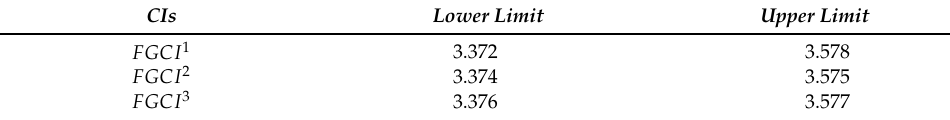
Table 4. Confidence intervals with 2.5% and 97.5% limits for